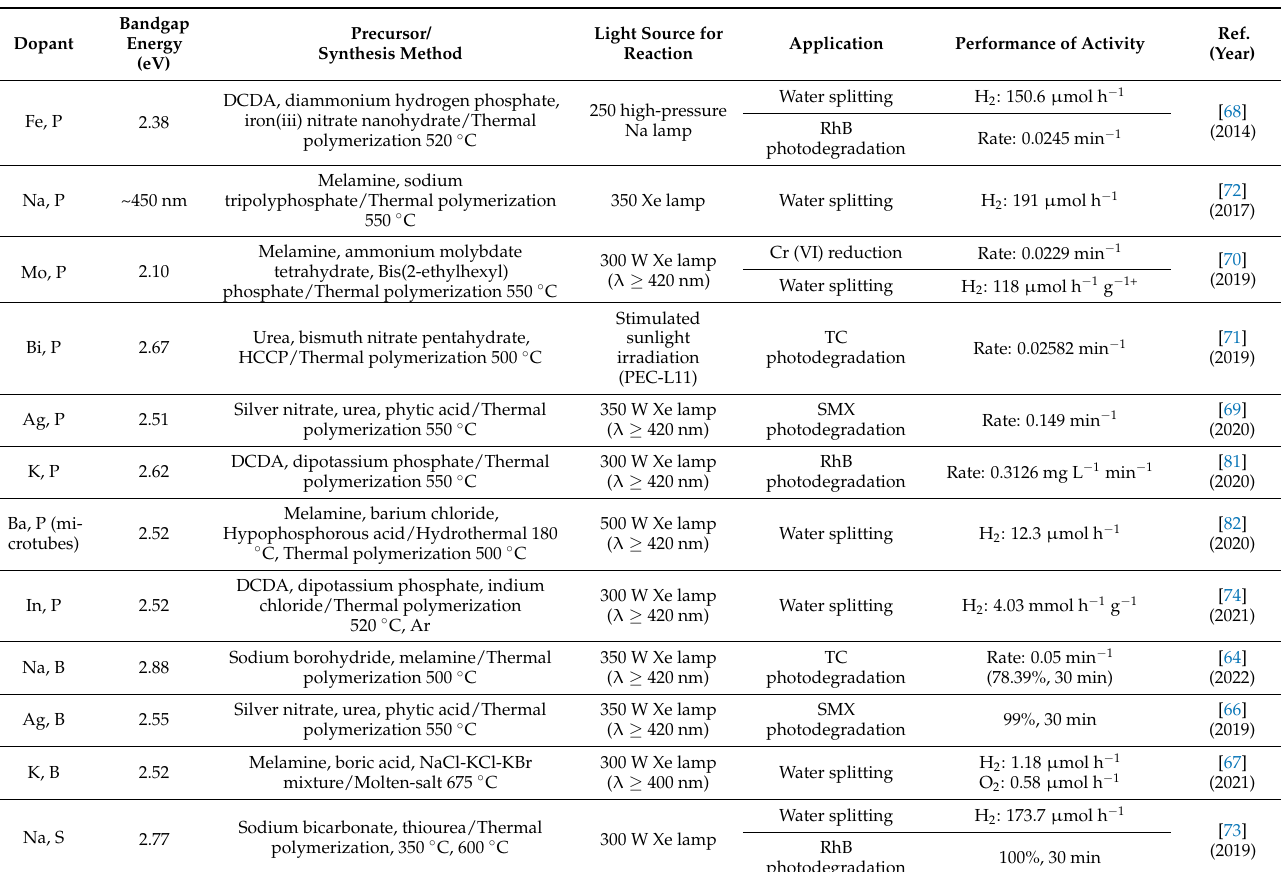
Table 1. The summary of metal-based co-doped